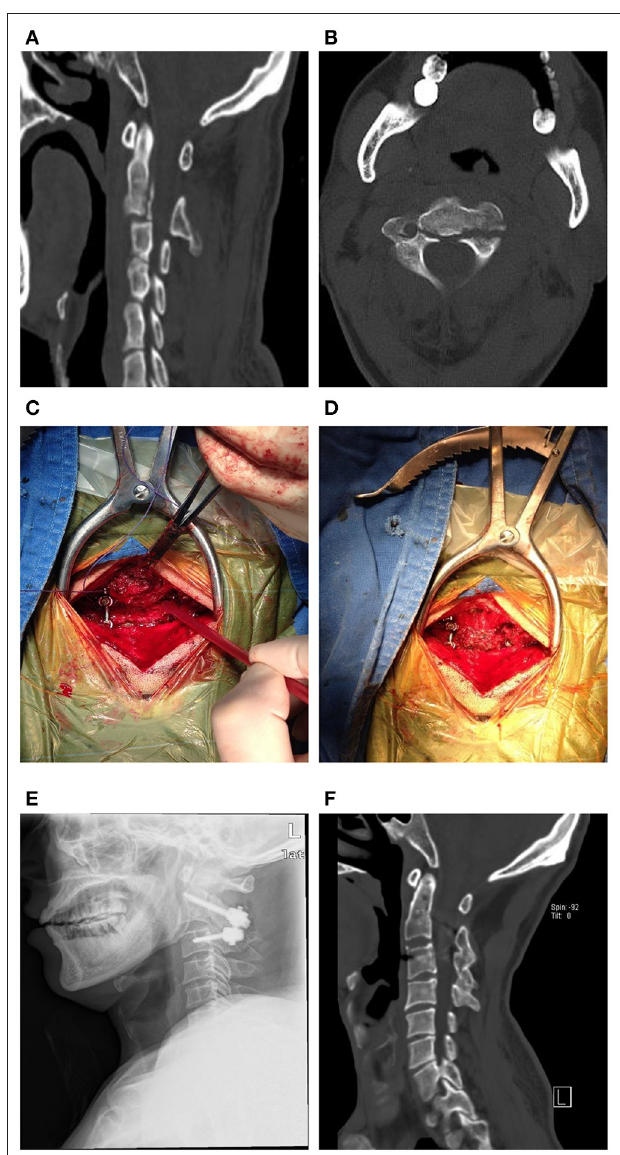
FIGURE 3 | (A,B) Preoperative cervical CT-scan of a 42-year-old male patient with instable Hangman fracture. (C,D) The screws were inserted in C2-3 pedicle and C2 spinous muscle complex was displaced into C2-3 posterior arch. (E) The postoperative X-ray showed good reduction and realignment. (F) The posterior cervical CT-scan at 1-year follow-up visit showed the bone fusion.